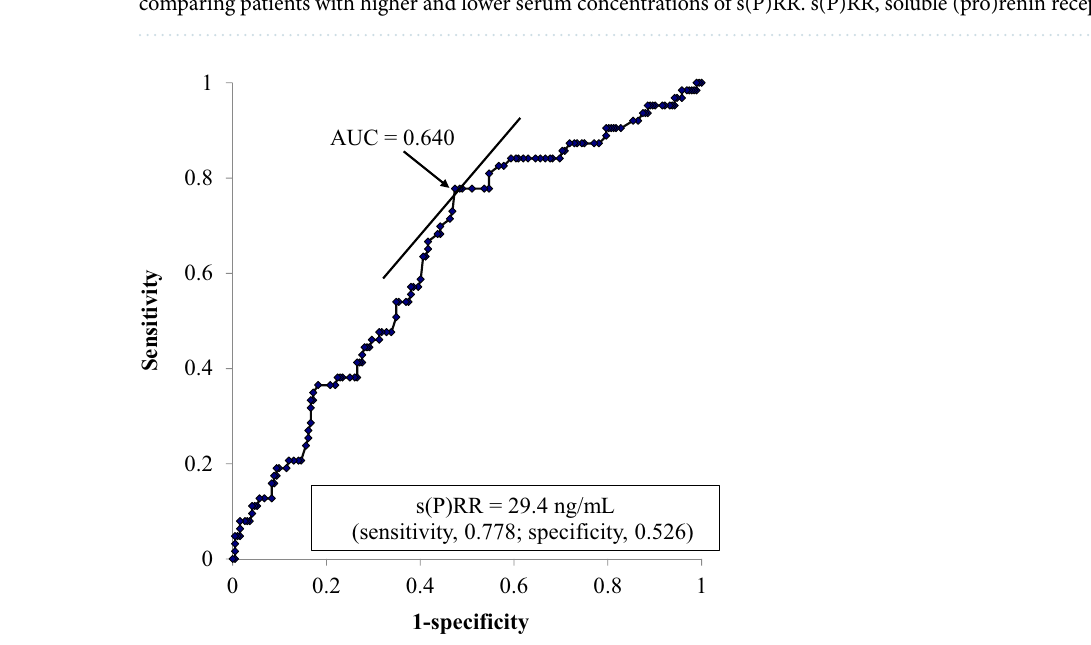
Figure 3. Receiver operating characteristic curve with area under the curve values. Discrimination value of s(P)RR for the survival rate using receiver operating characteristic analysis. AUC, area under the curve; s(P)RR, soluble (pro)renin